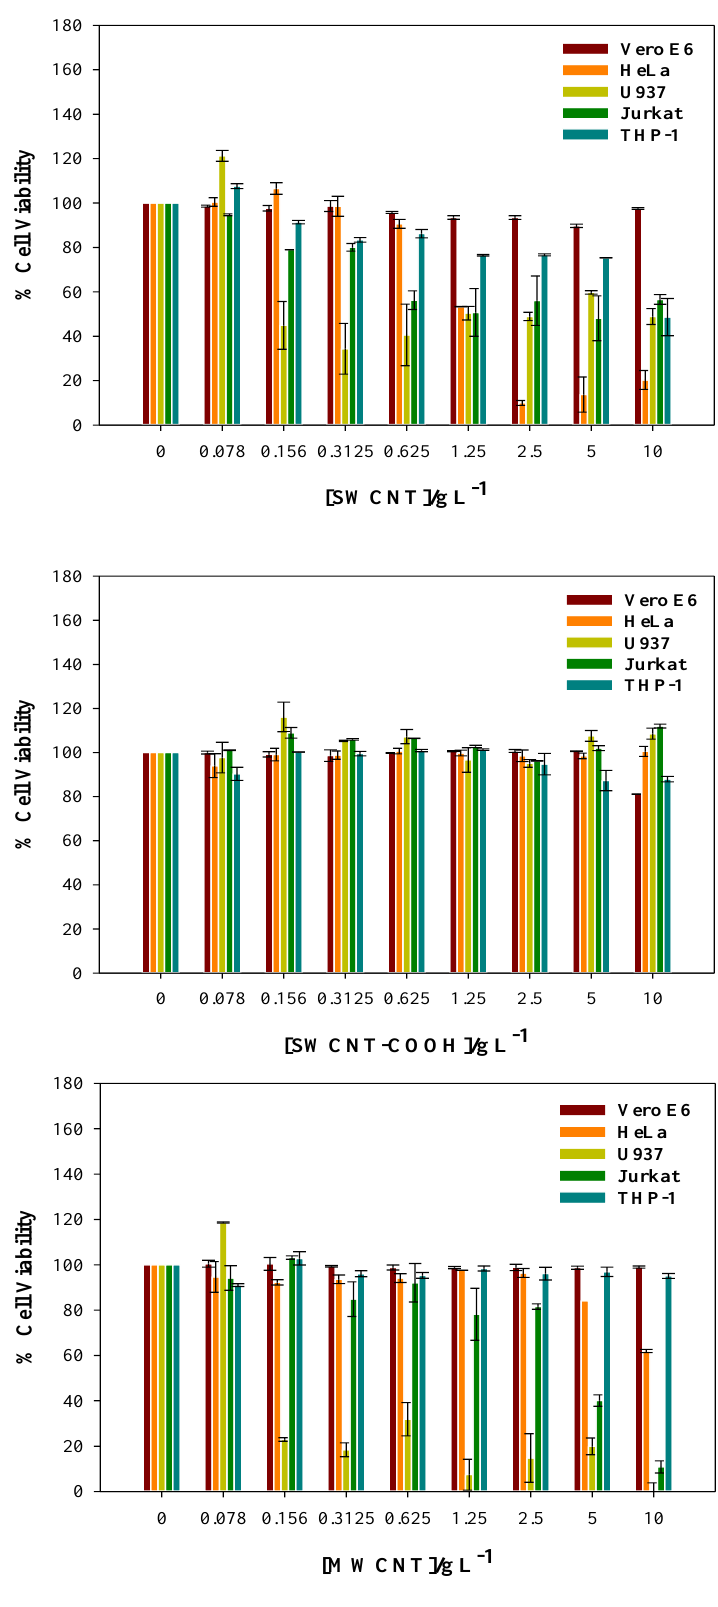
Figure 4. Cell viability of different carbon nanotubes in normal and cancer cell lines.